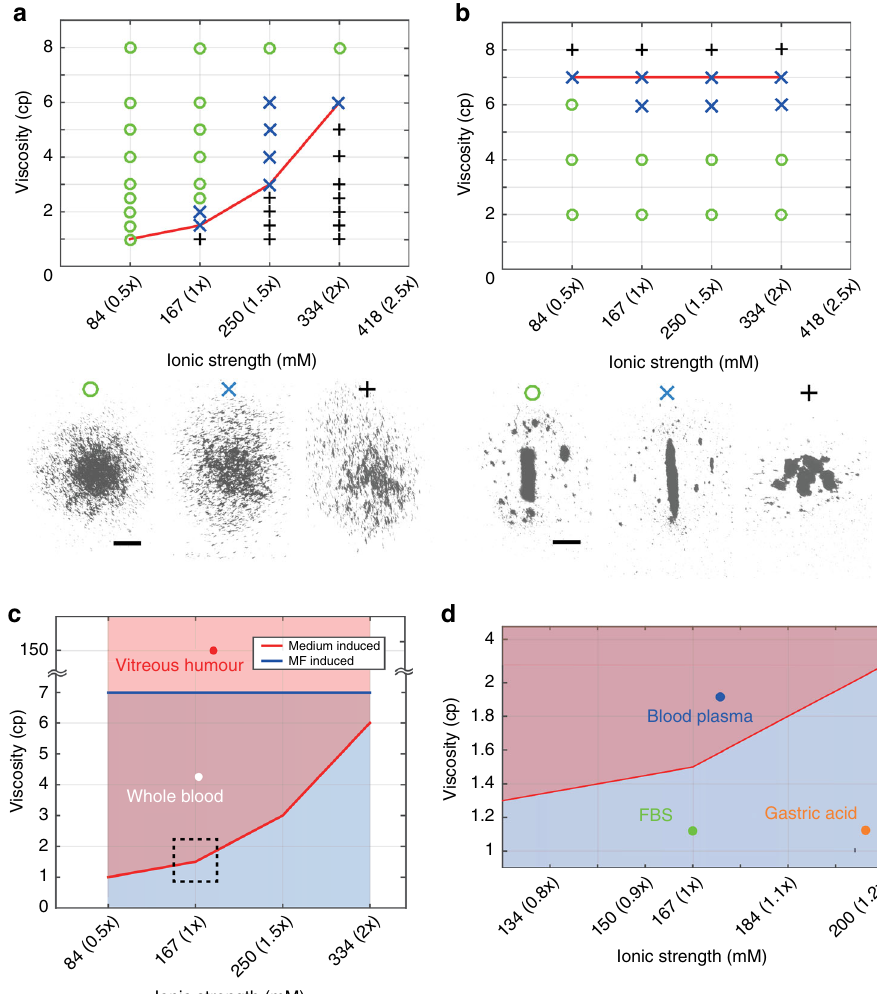
Fig. 3 Selection for the optimised swarms in different bio- fl uids. a Phase diagram for the generation states of the medium-induced swarms. The green circles, blue “ × ” and black crosses indicate successful generations, generation processes with relatively large loss rate of nanoparticles ( (cid:4) 40%), and failed generations with no swarm patterns, respectively. b Phase diagram for the generation states of the MF-induced swarms. Ribbon-like swarms which are capable of performing reversible elongation with a large aspect ratio ( (cid:5) 8) and with a restricted aspect ratio ( (cid:6) 3) are indicated by the green circles and blue “ ´ ” , respectively. Large clusters will form at the cases labelled by the black crosses. c The physical conditions of the fl uids that are proper for the generation of the medium-induced and the MF-induced swarms are highlighted by the red and blue regions, respectively. Based on the physical parameters of vitreous humour and whole blood, they are labelled by the red and white spots, respectively. d The zoom-in chart of the black dashed square in ( c ). Blood plasma, FBS and gastric acid are labelled using blue, green and orange spots, respectively. By judging the location of the spots, predictions can be made for the optimised swarm type that can be applied. The ionic strengths of the fl uids are normalised using PBS solution, and the ionic strength in PBS solution is 1.0 ´ . In c , d the viscosities are obtained at a shear rate of 10 s (cid:3) 1 . The scale bars indicate 500 μ m.